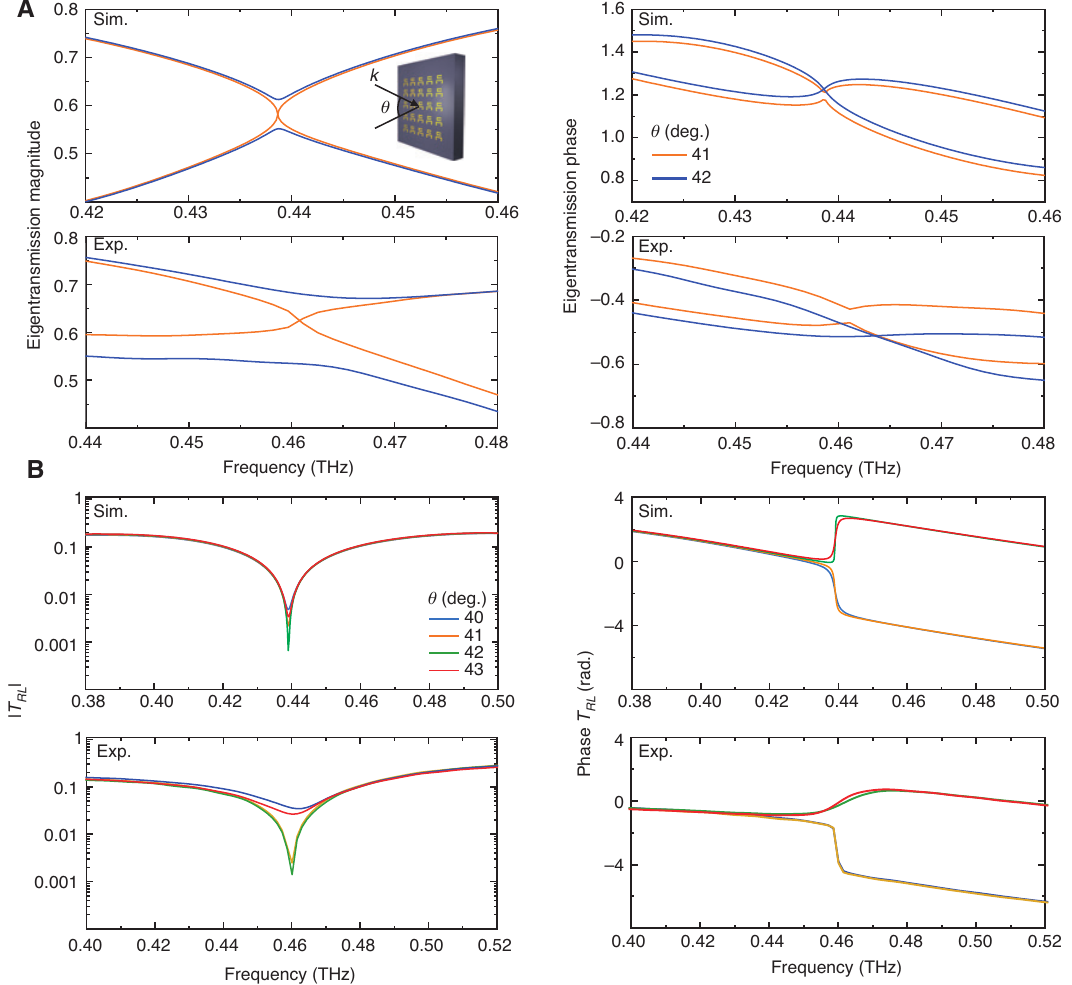
Figure 4: Eigenvalue surface topology and transmission phase singularity demonstrated by varying the incident angle of radiation. (A) The topology of the self-intersecting Riemann surface is observed in the [ ω , g varying G , we see that the crossing behavior of the eigenvalue magnitude and phase are interchanged as g xy simulation and experimental results, we find that the EP located between θ = 41 ° and 42 ° . (B) We observe an abrupt phase flip in T varied through the